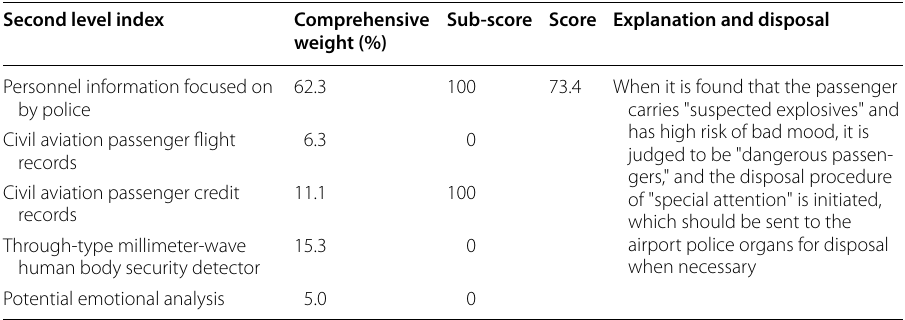
Table 14 Risk assessment results and disposal methods of case